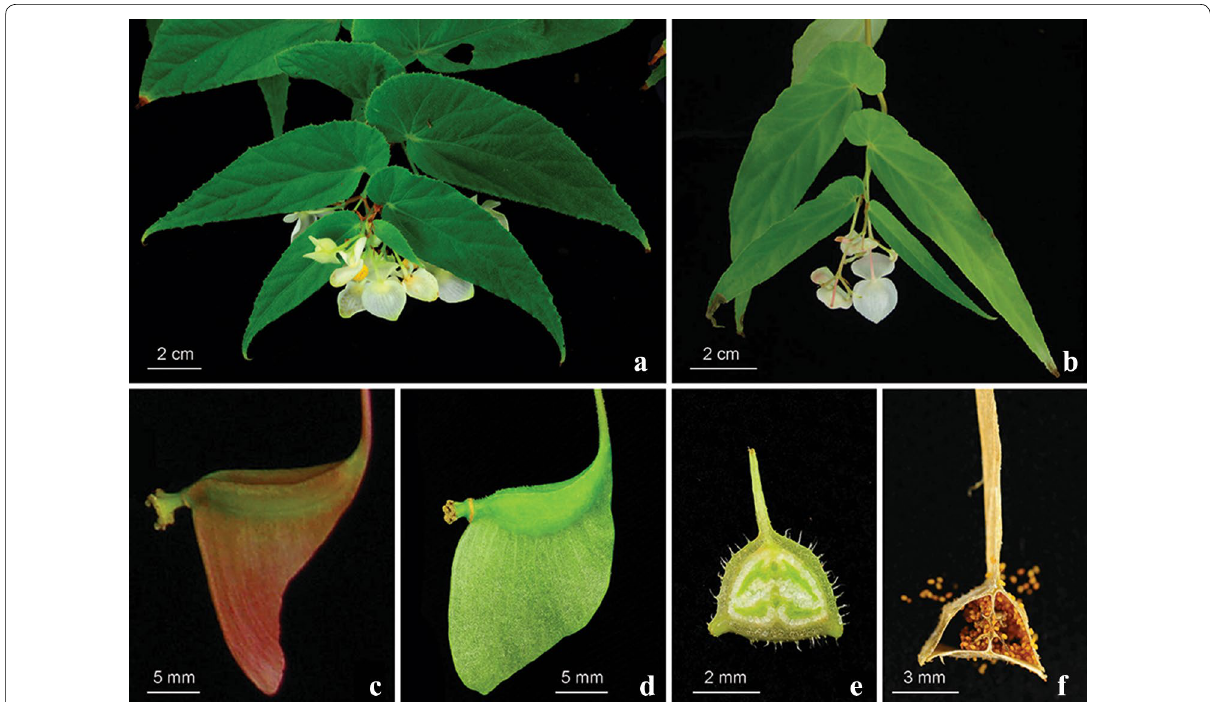
Fig. 3 Overview of leaves, fruit and cross section of ovary in Begonia griffithiana and B. nepalensis . a , b Leaves. c , d Fruit. e , f Cross section of ovary. Begonia griffithiana ( a , c , e ). Begonia nepalensis ( b , d , f )